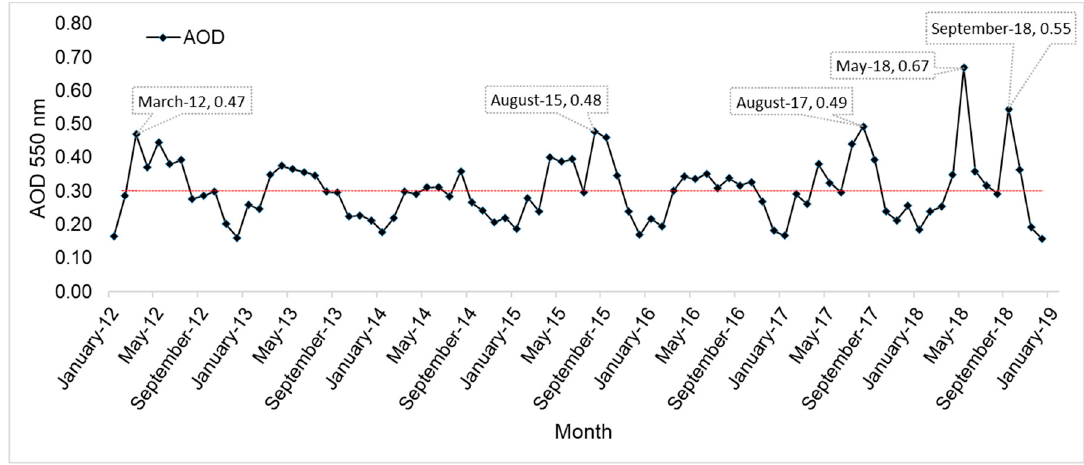
Figure 2. Time series of monthly AOD from MODIS Terra over Egypt (25°2 ′ 36 ″ E, 21°49 ′ 50 ″ N & 34°54 ′ 39 ″ E, 31°52 ′ 46 ″ N) for the period 2012 to 2018. The red line represents the reference value of AOD (mean AOD + standard deviation).